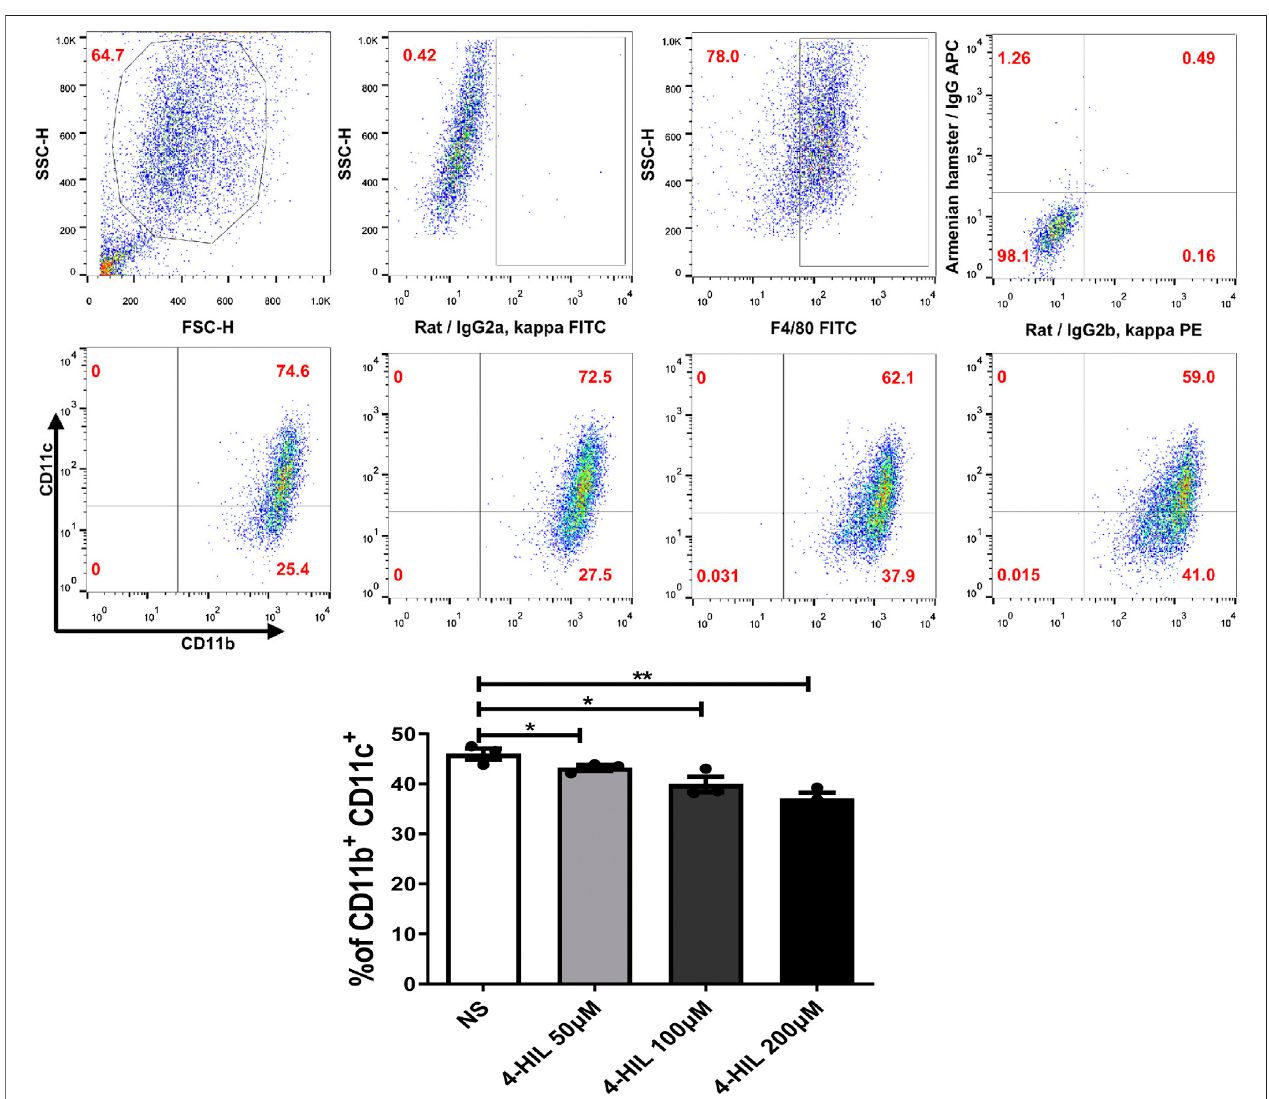
FIGURE 6 | Effect of 4-HIL on macrophages in vitro . Bone marrow-derived cells were cultured with GM-CSF (20 ng/ml) for 7 days. INF- γ (20 ng/ml) and LPS (100 ng/ml) was added on the day 6 and 7, respectively. After removing the non-adherent cells, the adherent cells were exposed to 4-HIL for 24 h. The proportion of macrophages was analyzed by fl ow